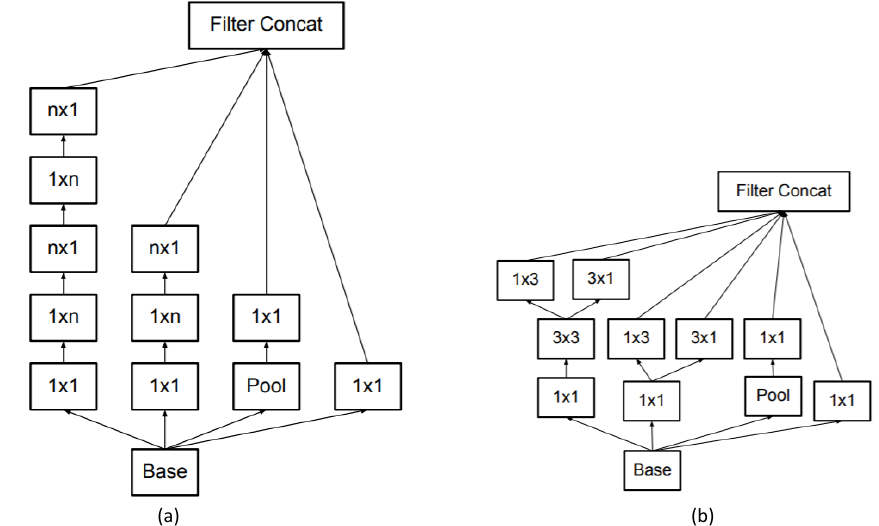
Figure 5. ( a ) Inception modules after the factorization of the n × n . convolutions. Here, n = 7; ( b ) Inception modules with expanded the filter bank outputs.